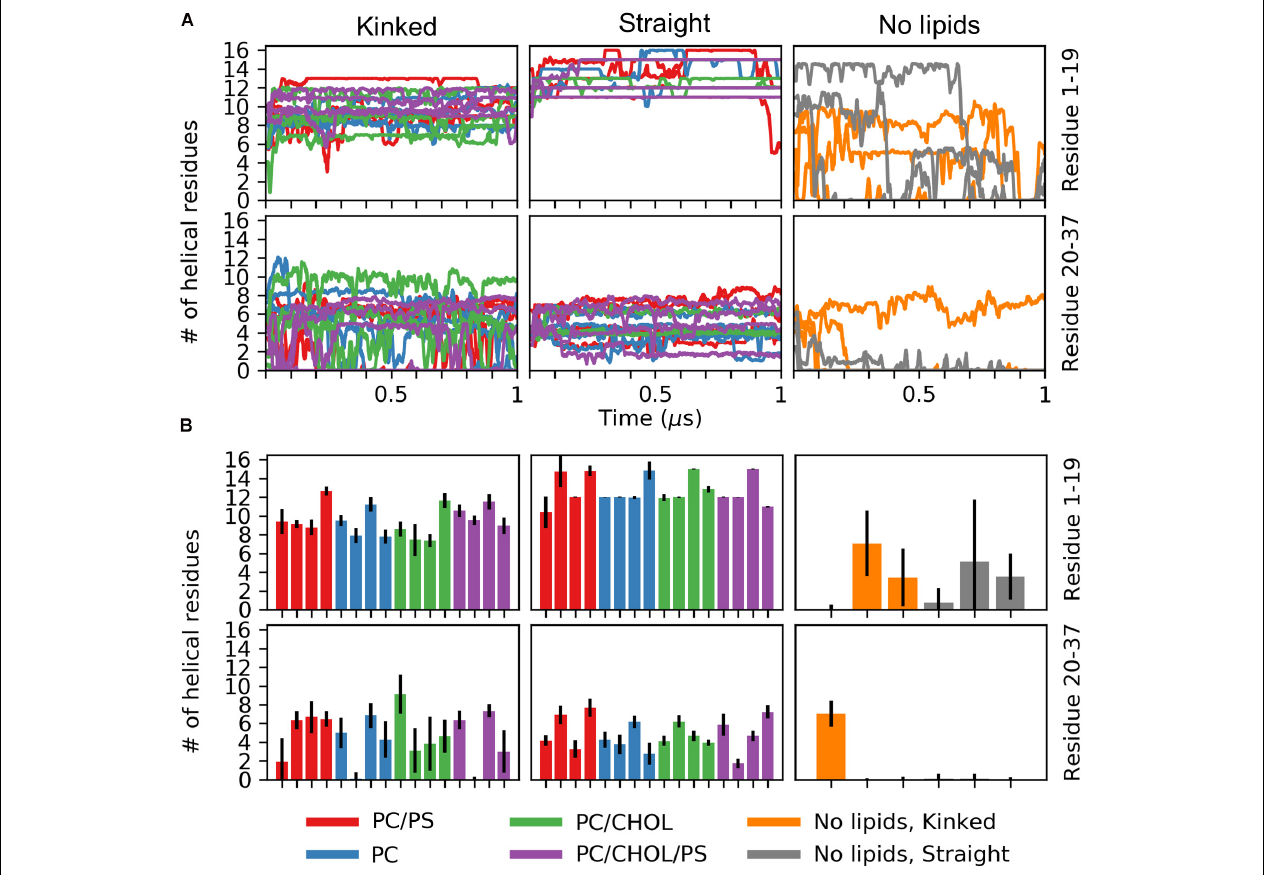
FIGURE 4 | Number of helical residues for each series of simulation (PC in blue, PC/CHOL in green, PC/PS in red, and PC/PS/CHOL in purple). The number of helical residues is plotted separately for the N-terminus (residue 1–19, first row) and the C-terminal (residue 20–37, second row) and separated for the peptides starting in the kinked conformation and the straight conformation. (A) The development of the number of residues in a helical conformation in time. (B) Mean and standard deviation of the number of helical residues in each of the simulation